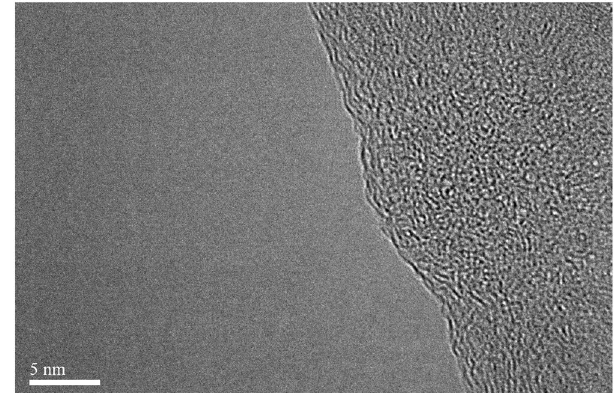
Figure 3. HRTEM image of thin GO sheet.